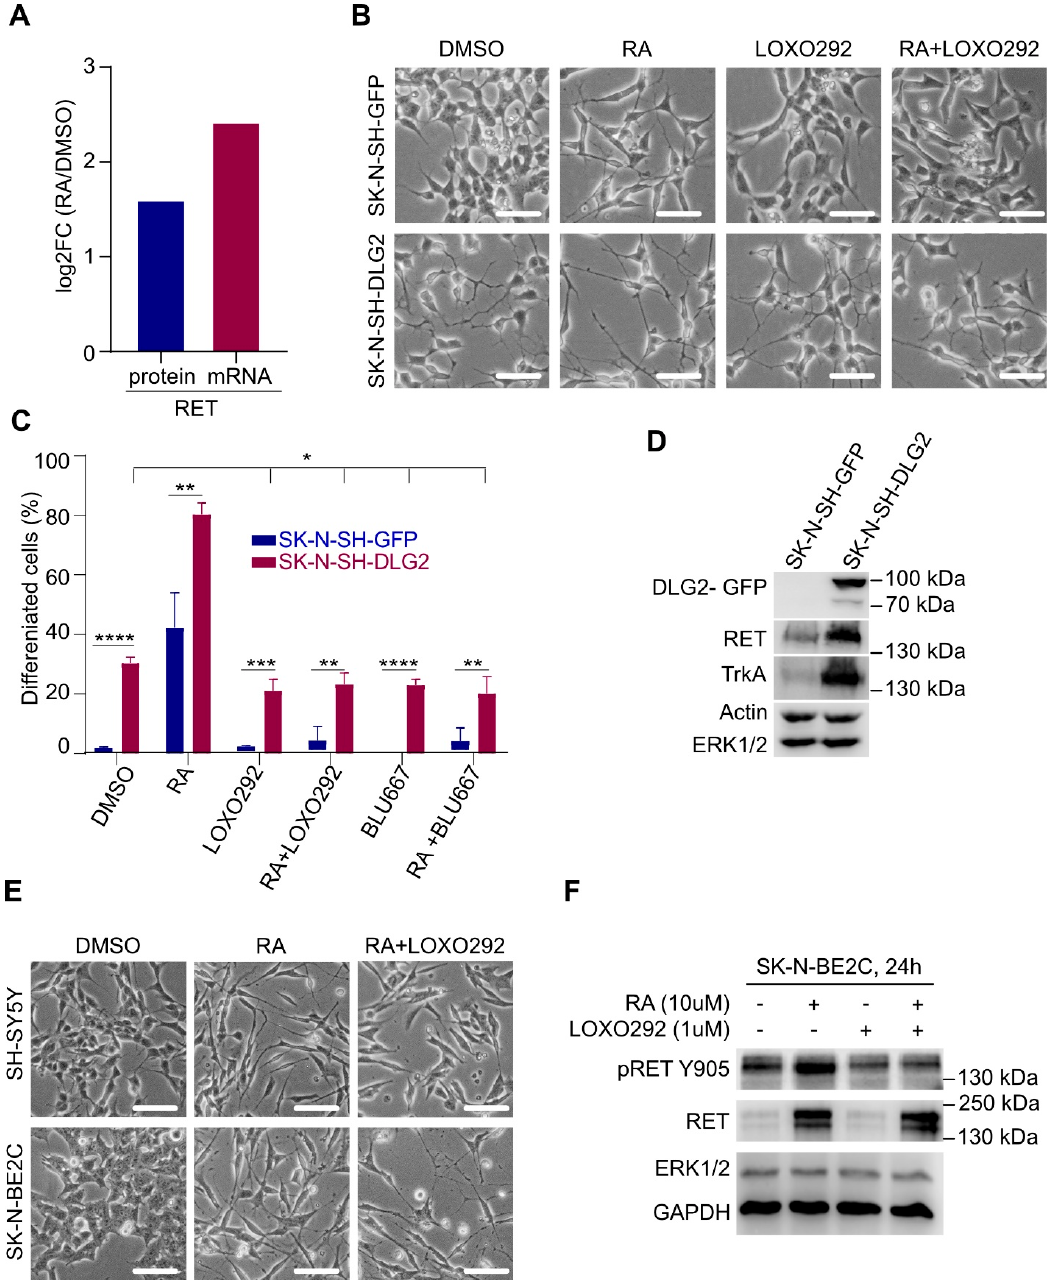
Figure 9. RET is required for context-dependent differentiation of NB cells. ( A ) Bar chart showing the effect of 13- cis retinoic acid (RA) on RET protein and mRNA expression from proteomic and RNA-seq data. SH-SY5Y NB cells were treated with either DMSO or RA (10 µ M) for 24 h. Proteomic and RNA-seq datasets were previously published by Siaw et al. [43] p -adj = 0 for log 2 FC (RA/DMSO) for both RET protein and mRNA. ( B ) Representative images (scale bar = 50 μ m) and ( C ) quantification of discs large homolog 2 (DLG2)- or RA-induced morphological differentiation in SK-N-SH-GFP and SK-N-SH-DLG2 NB cells, in the presence and absence of RET inhibitors (LOXO292 and BLU667). * p <0.5, ** p <0.05, *** p <0.005, **** p <0.0005. ( D ) Western blot confirming DLG2 overexpression and its effect on expression of neuronal differentiation markers . ( E ) Representative images (scale bar = 50 μ m) showing effect of LOXO292 on RA-induced morphological differentiation in SH-SY5Y and SK-N-BE2C NB cell lines. ( F ) Western blot analysis of RET expression and phosphorylation in SK-N-BE2C cells with indicated treatments for 24 h.